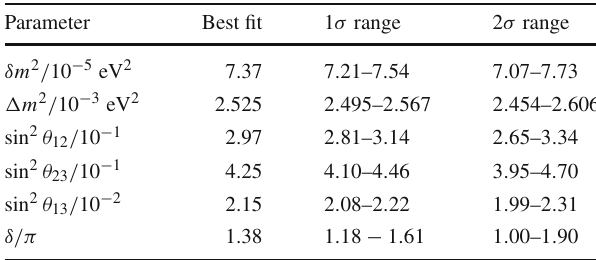
Table 1 Input values for the neutrino oscillation parameters we use in this paper. We take them from Ref. [51]